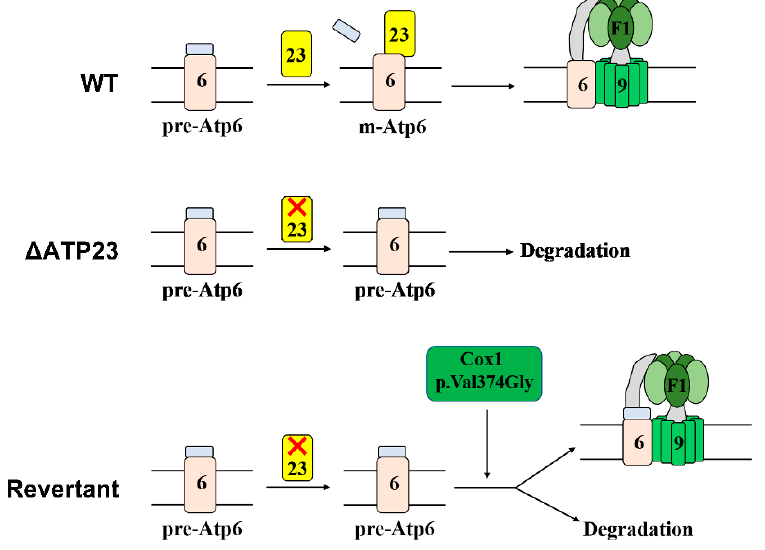
Figure 6. Model of the partial assembly of mitochondrial ATP synthase in revertant of atp23 null mutant. The top panel shows that, in the presence of Atp23, Atp6 precursor (pre-Atp6) is processed into mature Atp6 (m-Atp6) and mitochondrial ATP synthase is assembled. The middle panel shows that, due to a lack of Atp23, the Atp6 precursor is degraded and no mitochondrial ATP synthase is assembled. The bottom panel shows that, in revertant of atp23 null mutant, Cox1 p.Val374Gly point mutation stabilizes some pre-Atp6 and results in the partial assembly of the ATP synthase. Meanwhile, some pre-Atp6 is